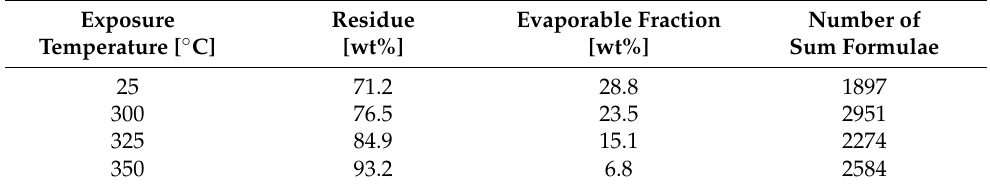
Table 2. Percentage of evaporable organic compounds, residue and the number of attributed sum formulae in fibers from thermally stressed C 3 (25, 300, 325 and 350 ◦ C, air atmosphere, 3 h) measured by TA-APPI-MS (10 K/min, 600 ◦ C, hold for 10 min). Compounds evaporating during the